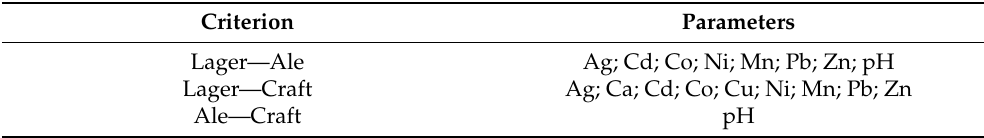
Table 7. Parameters for which there were statistically significant differences in terms of beer type ( n =